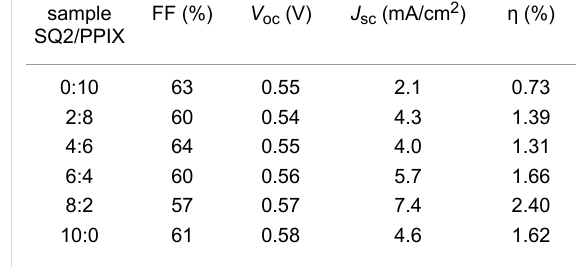
Table 3: Solar cell performances using dyes with different molar ratios of SQ2 and PPIX as